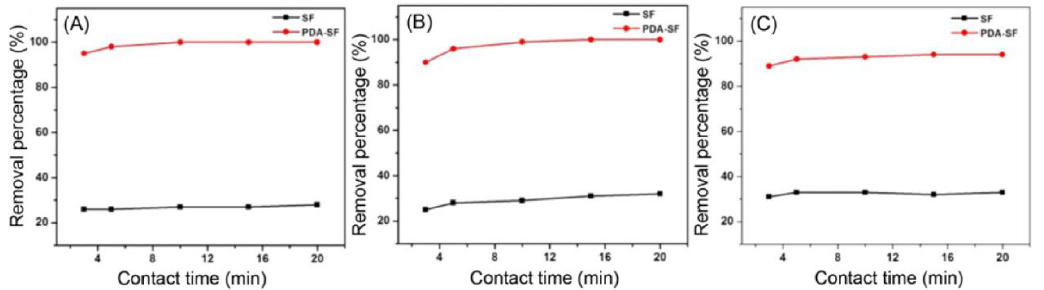
Figure 11. SF amount experiments on Cd 2+ ( A ), Cu 2+ ( B ) and Ni 2+ ( C ). Adapted from Reference [60]. Copyright 2021, Korean Fiber Society. Copyright 2021, Korean Fiber